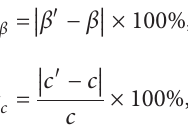
Table 2. ε and ε c are the measurement errors of crack β position and local flexibility.